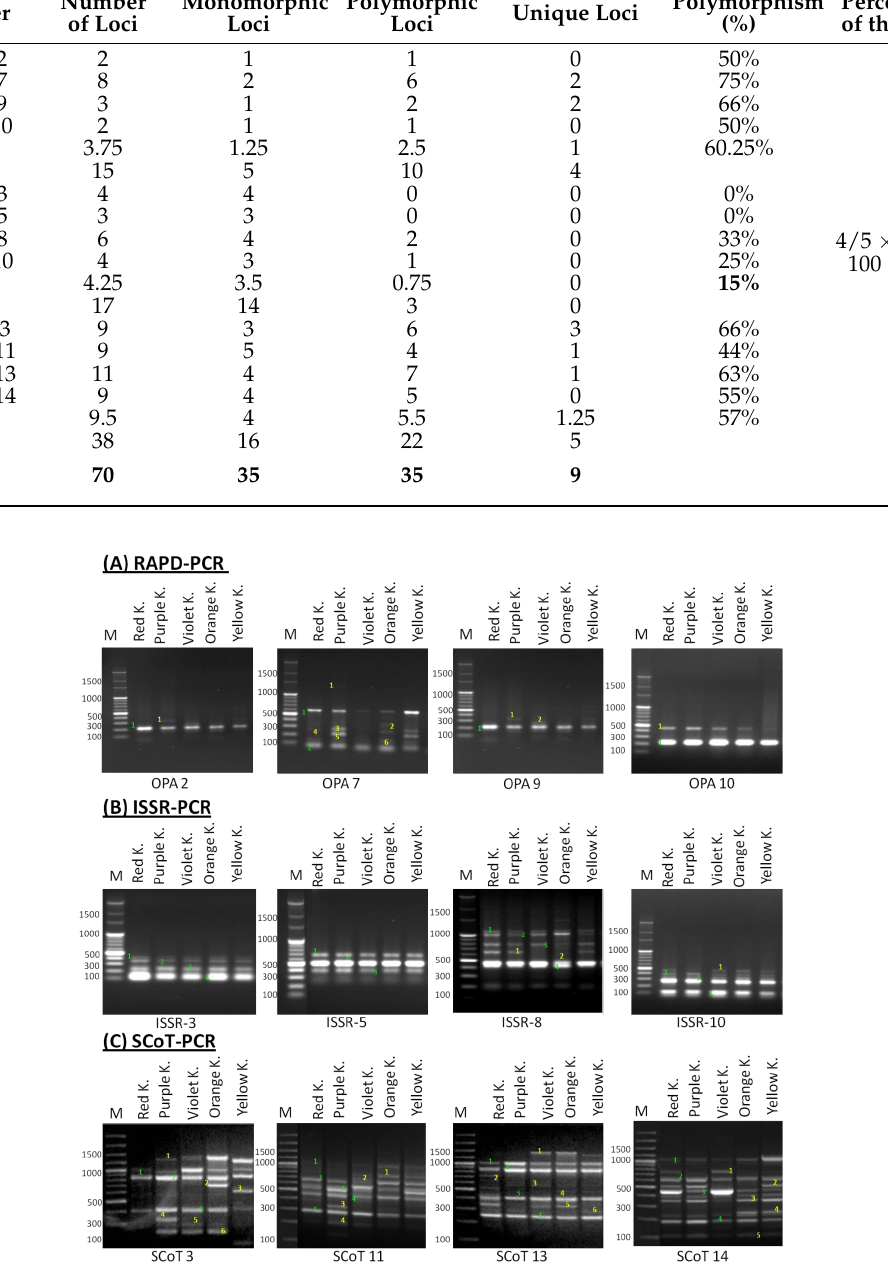
Figure 3. DNA fragment patterns of RAPD, ISSR and SCoT-PCR amplification of five kalanchoe genotypes. ( A ) RAPD-PCR amplification using primers OPA 2, OPA 7, OPA 9 and OPA 10, respec- tively. ( B ) ISSR-PCR amplification using primers ISSR-3, ISSR-5, ISSR-8 and ISSR-10, respectively. ( C ) SCoT-PCR amplification using primers SCoT3, SCoT11, SCoT13 and SCoT14, respectively. M = 100bp Plus DNA Ladder. The monomorphic loci are presented in green numbers and the polymor- phic loci are presented in yellow numbers. 2.3. Phylogeny Analyses Phylogenetic relationships among the five kalanchoe genotypes were inferred based on the data recorded from morphological criteria. The clustering analysis grouped the five kalanchoe genotypes into two groups (I, II) (Figure 4). Cluster I comprised the violet and the orange kalanchoe genotypes and cluster II included red, yellow and purple kalanchoe genotypes. On the other hand, the phylogenetic relationship was determined among the kalanchoe genotypes based on the banding profiles revealed by RAPD, ISSR and SCoT- PCR. Phylogenetic analysis (Figure 5) divided the five kalanchoe genotypes into three clusters according to the data scored from the molecular analysis. Yellow kalanchoe